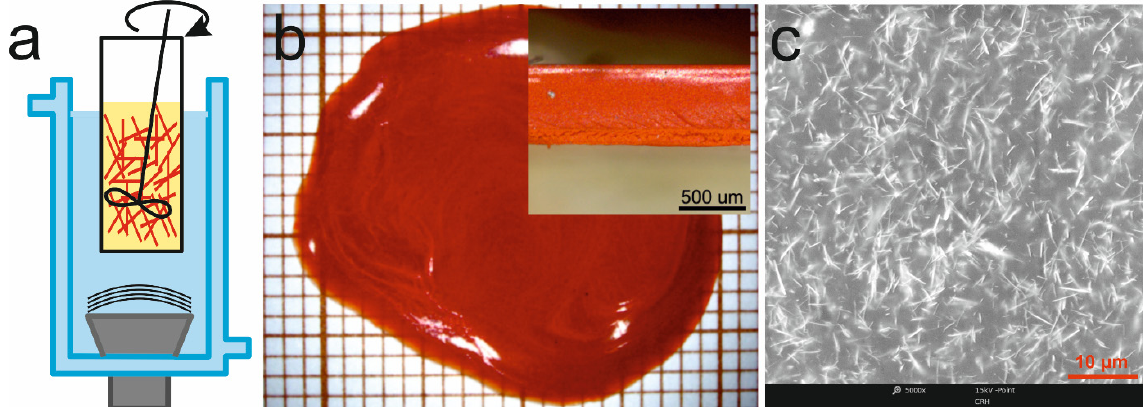
Figure 5. Schematic diagram for the fabrication of an epoxy resin/SbSI composite. ( a ) Preparation of a homogeneous mixture of SbSI nanowires, epoxy resin, and a hardener. ( b ) Photograph and ( c ) SEM image of the epoxy resin/SbSI composite. The inset of ( b ) displays the cross-section of the obtained composite plate.